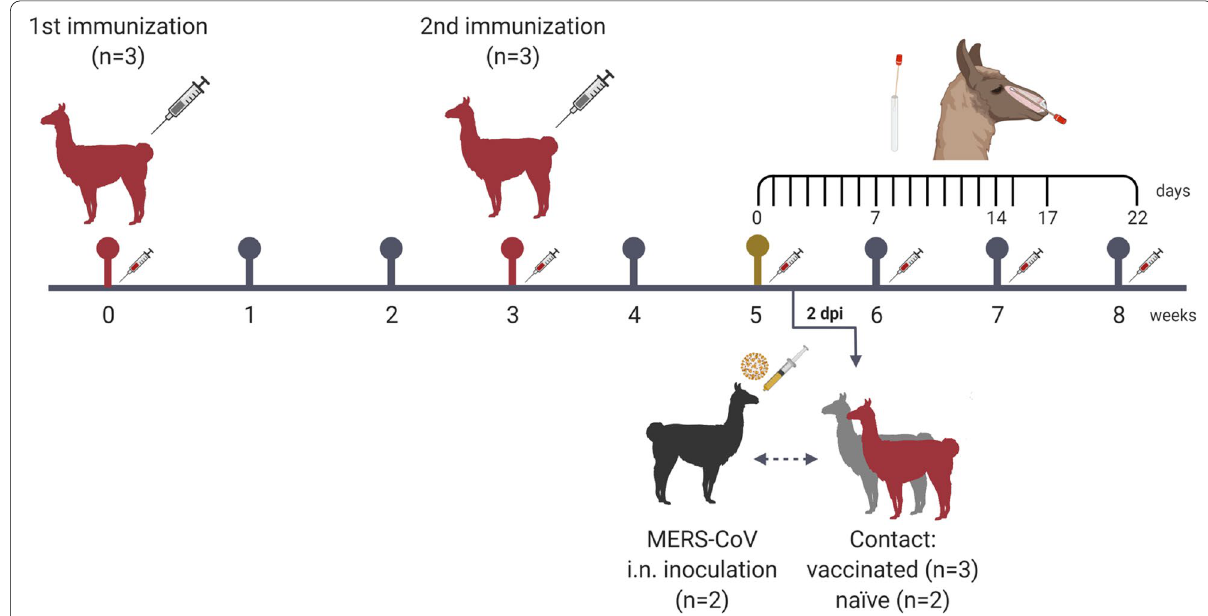
Fig. 1 Schematic representation of the experimental design. Two llamas (black) were intranasally inoculated with MERS‑CoV (Qatar15/2015) and two days later brought in contact with two naïve (grey) and three vaccinated (red) llamas. Immunization dates are shown in red timeline points and with grey syringes. MERS‑CoV‑inoculation procedure is stressed as a gold time point. Blood collection days are represented with a red syringe symbol on the weeks scale. Sampling scheme of nasal swabs in all animals is shown using black lines in a daily scale. Dpi, days post‑inoculation; i.n.,